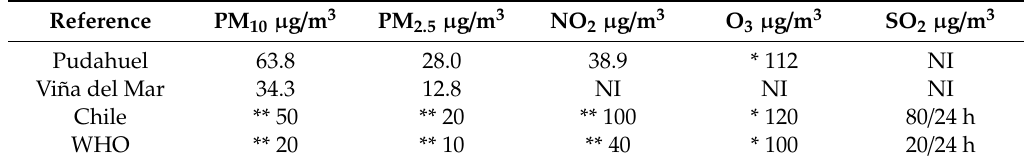
Table 2. Registration of three-yearly average concentrations (2012–2013–2014) and reference limit values of the World Health Organization (WHO) and